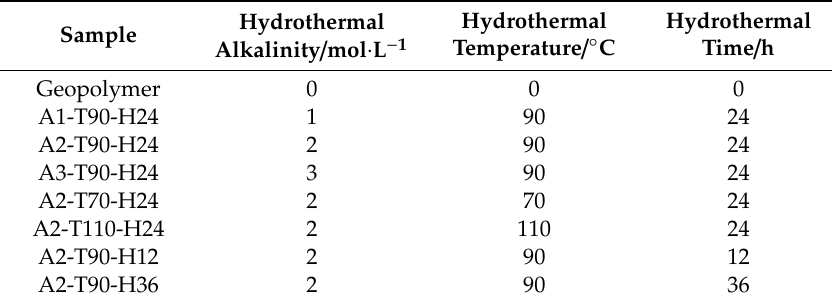
Table 2. Samples and tested hydrothermal